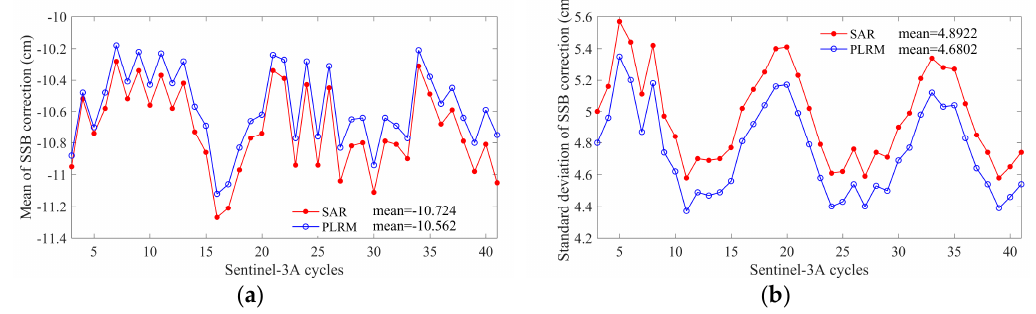
Figure 8. Cycle by cycle ( a ) means and ( b ) standard deviations of SSB corrections according to Sentinel-3A repeat cycles.